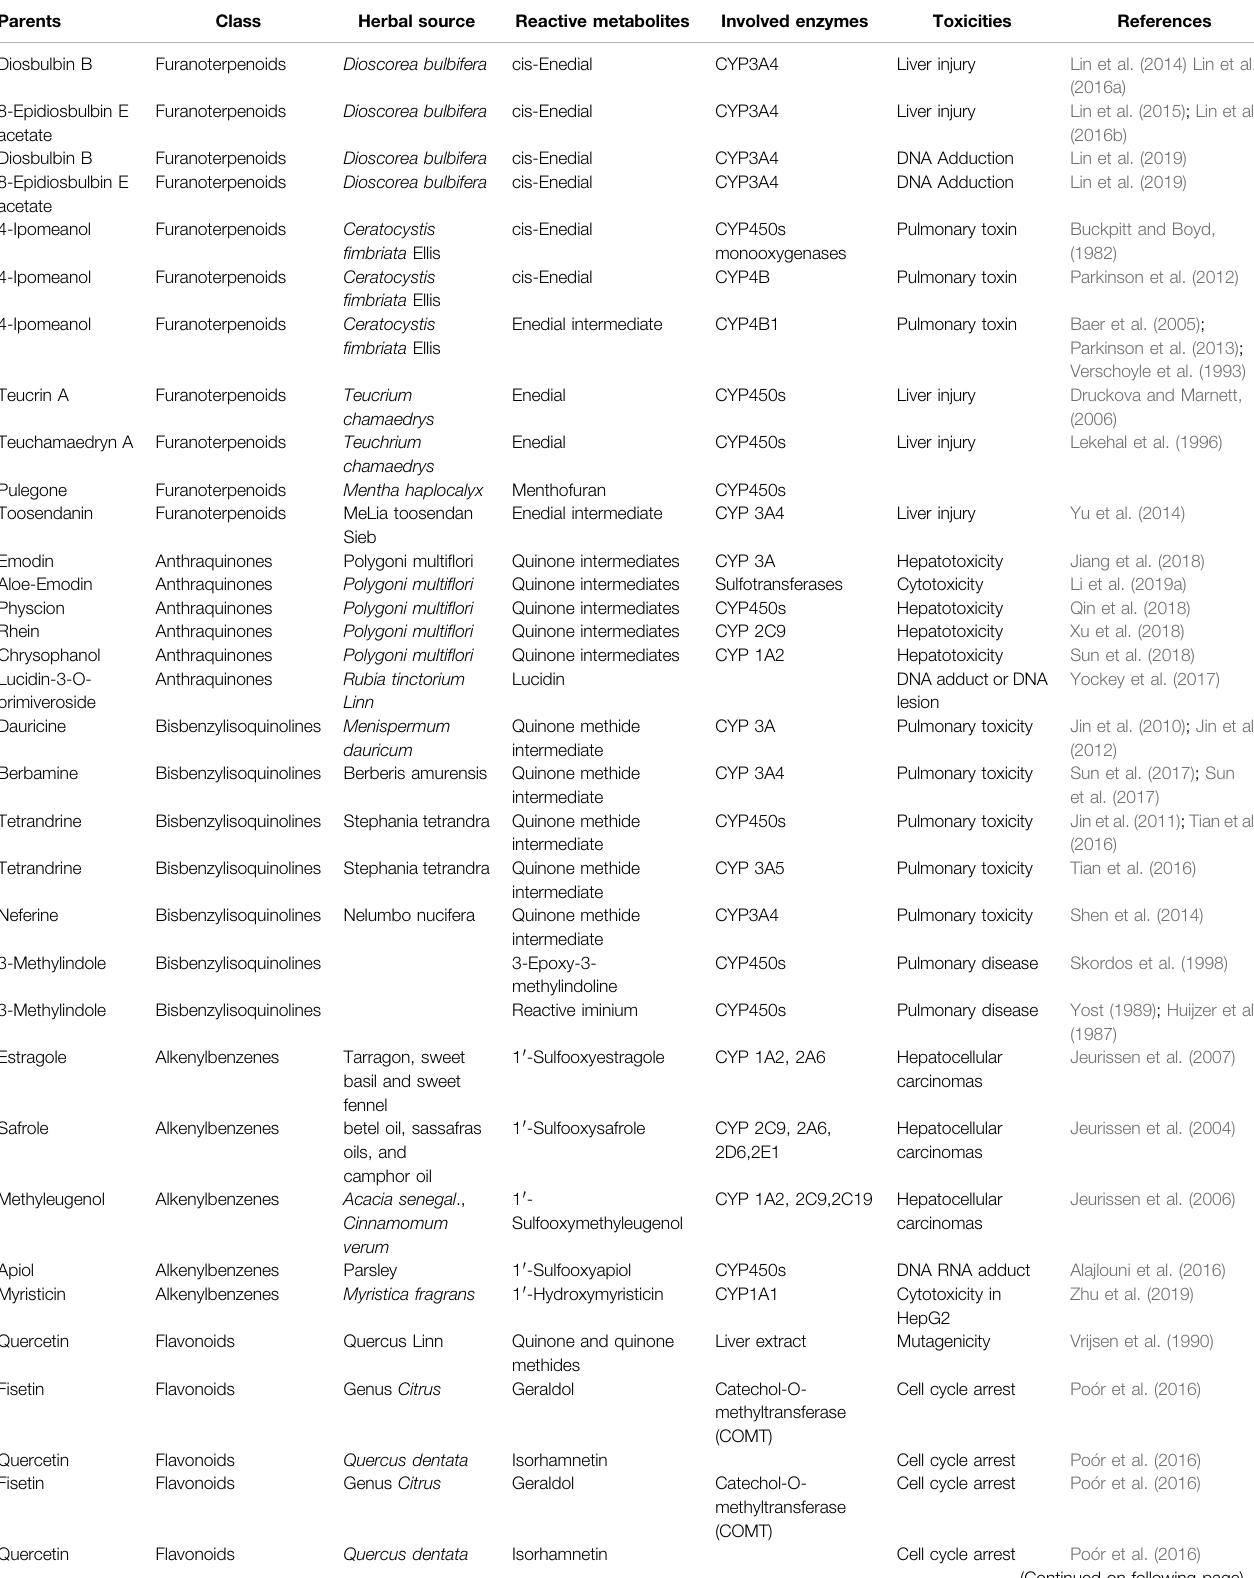
TABLE 1 | Metabolic activation of natural products in their